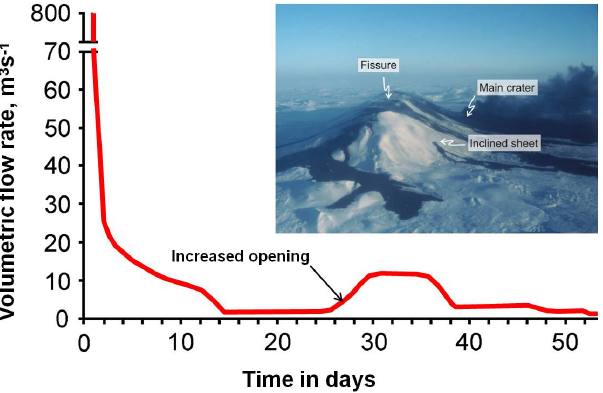
Fig. 11. Variation in the volumetric flow or effusion rate in the 1991 Hekla eruption in Iceland as a function of time. The abrupt increase in the volumetric flow rate is here thought to be related to a small increase in the opening (aperture) of the feeder dyke. On the in- set is a photograph of the Hekla Volcano early in the eruption (cf. Gudmundsson et al.,